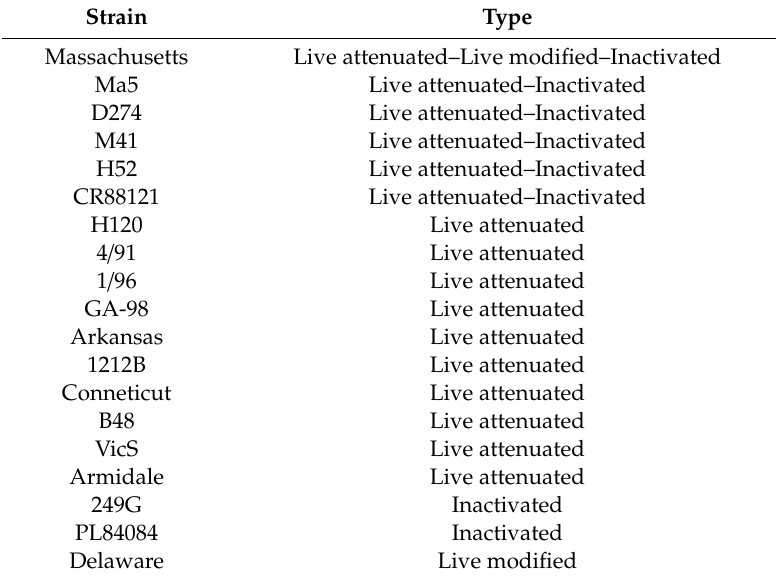
Table 1. Main vaccines available by strain and